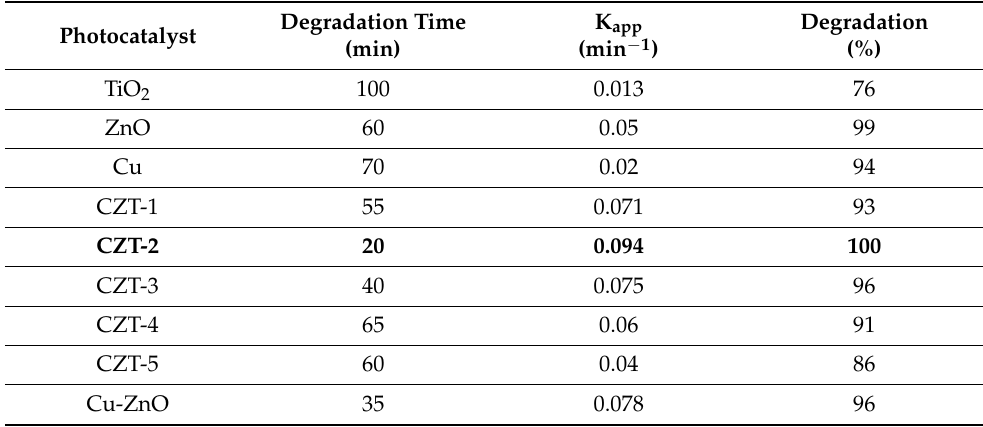
Figure 6. UV-Visible absorption spectra for the CR degradation with time over CZT-2 nanocomposite photocatalyst (reaction conditions: CR dye = 75 mg/L, catalyst loading = 0.5 g/L, sunlight irradiation = 20 min). Table 2. Photocatalytic performance of the prepared nanocomposite photocatalysts for CR degradation (reaction conditions: CR dye = 75 mg/L, catalyst loading = 0.5 g/L).